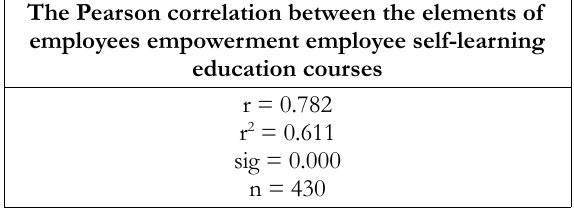
Table 4. the Pearson correlation between the elements of promotion of professional